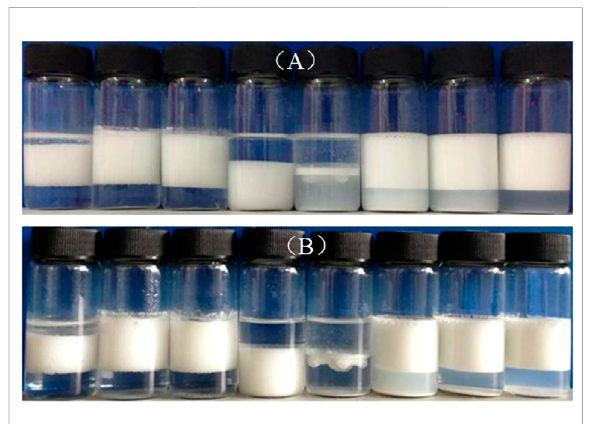
FIGURE 6 Appearance of toluene – water emulsions stabilized by 1.0 wt % CaCO 3 nanoparticles together with SDS at different concentration (from left to right): 3 × 10 − 4 , 6 × 10 − 4 , 1 × 10 − 3 (O/W (1)), 3 × 10 − 3 (W/O), 6 × 10 − 3 (unstable), 1 × 10 − 2 , 3 × 10 − 2 ,